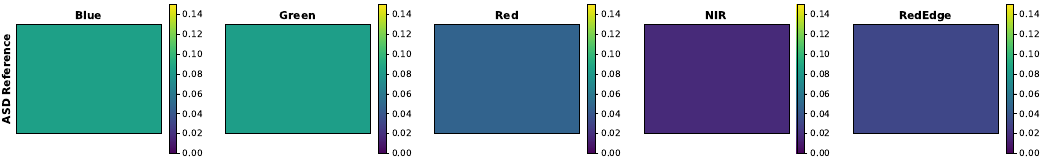
Figure 18. ASD reference values measured of the integrating sphere during calibration testing. RedEdge-3 RSR curves applied to ASD spectra to compute band integrated radiances, which are being displayed as